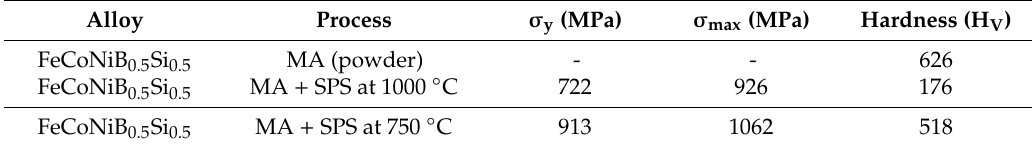
Table 7. Mechanical properties: compressive strength ( σ max ), yield strength ( σ y ) and Vickers hardness. Alloy Process